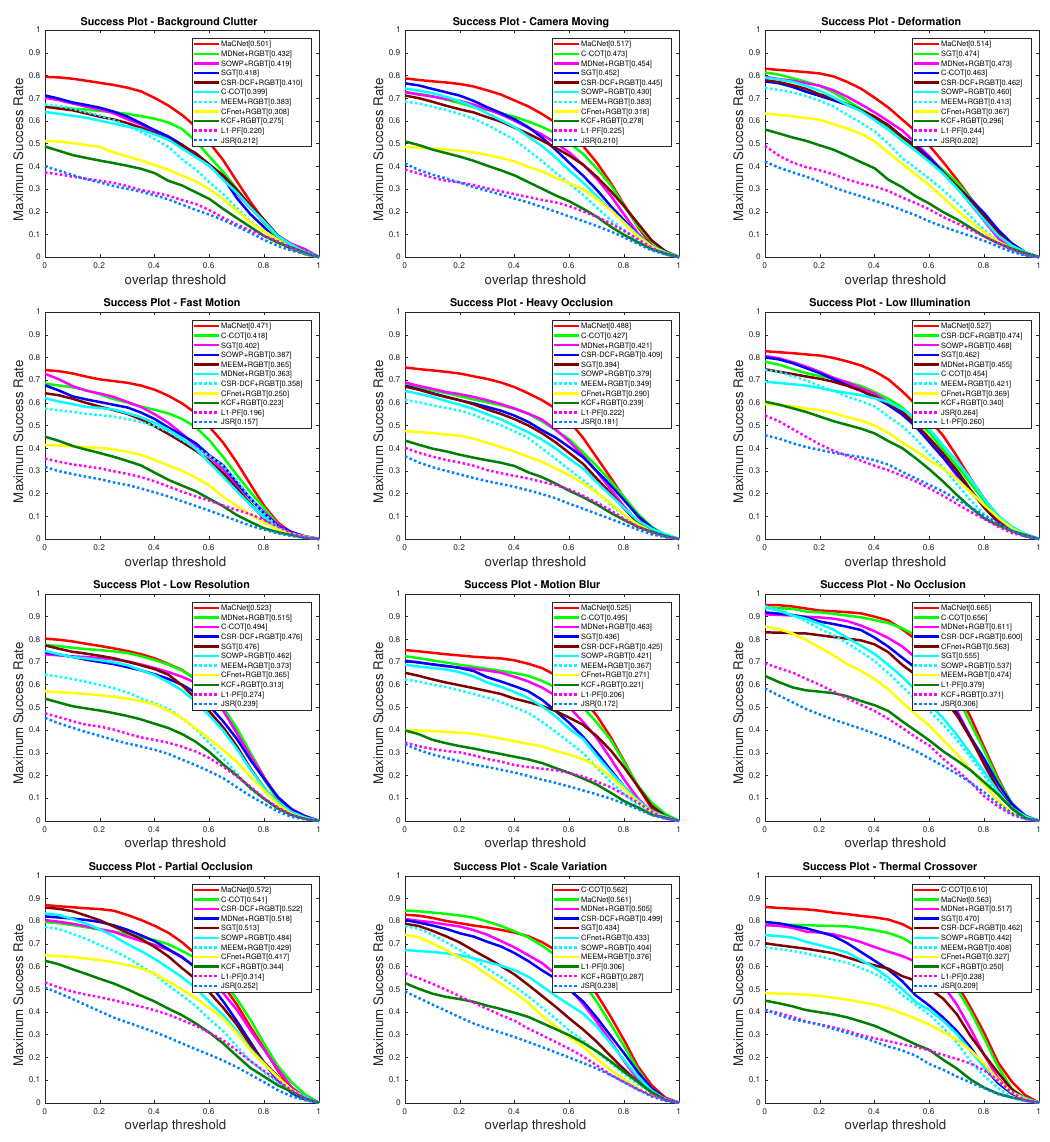
Figure 6. SR evaluation results on various attribute challenges comparing to ten state-of-the-art approaches on RGBT234